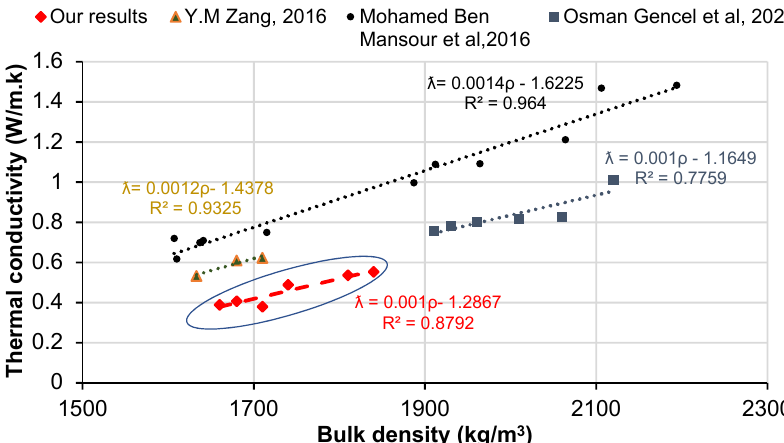
Figure 12. Relationship between thermal conductivity and brick Figure 9. Relationship between thermal conductivity and brick density.